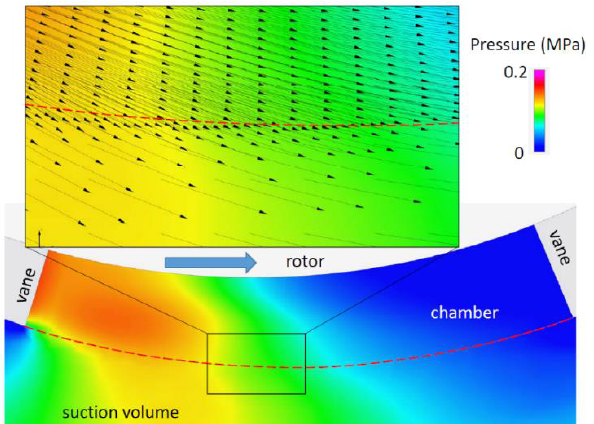
Figure 9. Pressure field in the upper milling—cover side (Plane A) and detail of the velocity field in Configuration 3, at 120 degrees and at 55% of the maximum displacement.